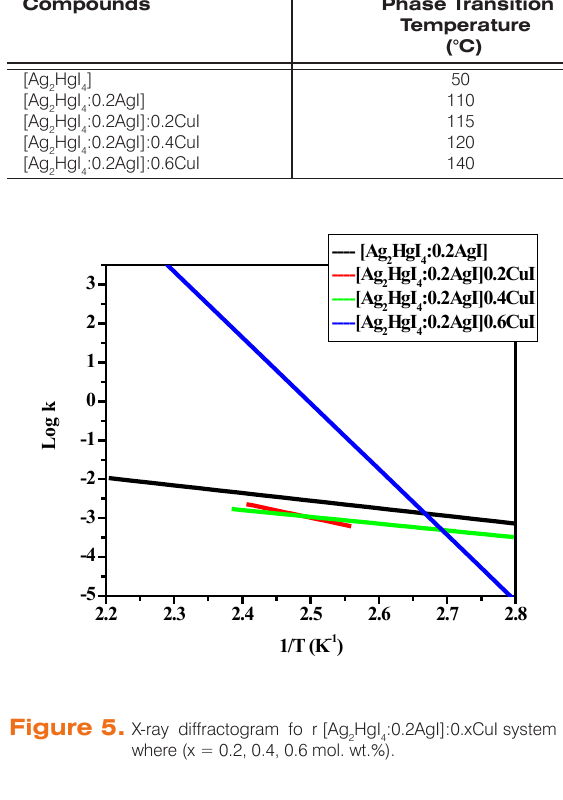
HgI :0.2AgI] doped with different 2 4